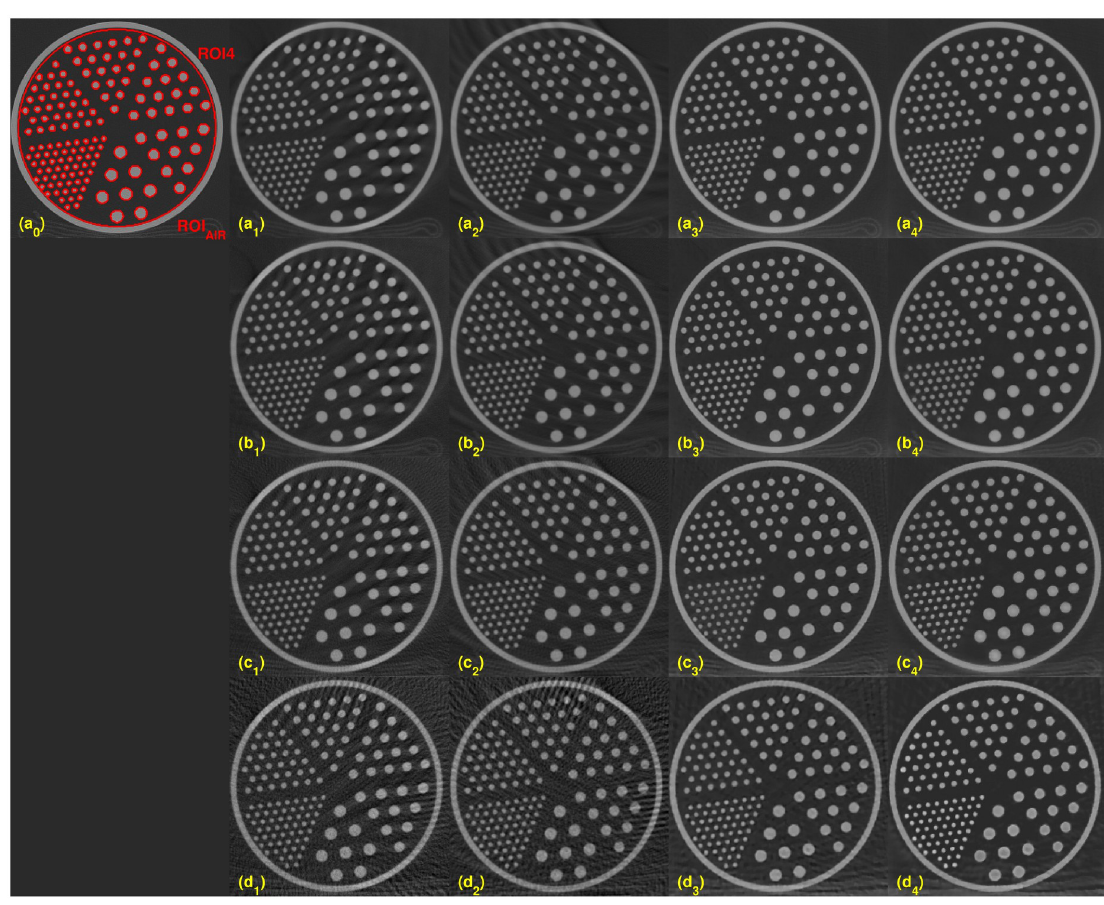
Fig 7. Reconstucted images with various sampling step sizes. From top to bottom, the sampling step size is set to be 1, 4, 8, and 16. Each column consists of a different reconstruction algorithm, from left to right: scanner, FDK, Katsevich, TV and the TF algorithm. The image on (a 0 ) shows ROI4 and ROI AIR